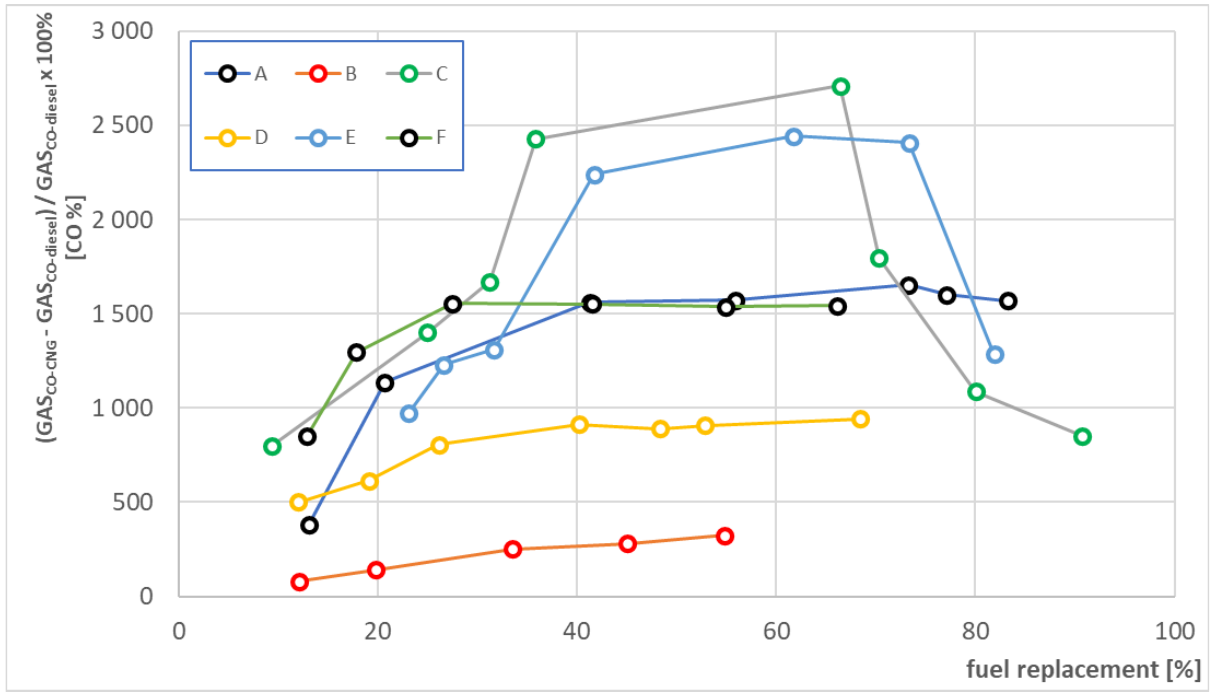
Figure 4. Emission changes of carbon monoxide in the exhaust gas for individual engine operating points (rotation speed, torque) in comparison to point zero of replacing diesel/CNG as a function of replacing diesel/CNG. Curves from A to F showing the changes of the emission of carbon monoxide as the comparison of exhaust gas temperature noted only in single fuel (diesel) working mode for individual engine operating points, where the rotation speed, power, and torque were constant, as a dual fuel mode (where engine uses CNG and diesel fuel) replacement